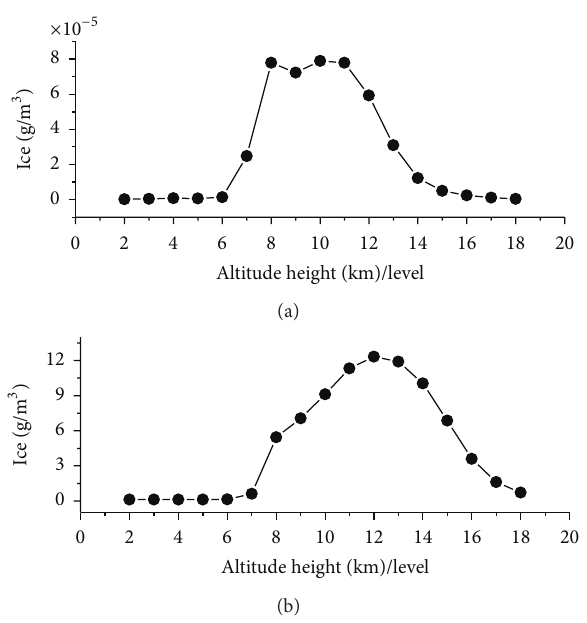
Figure 3: Distribution of cloud ice concentration as a function of altitude averaged during 2000–2011 period (a) over the continental region L1 and (b) oceanic region O2.